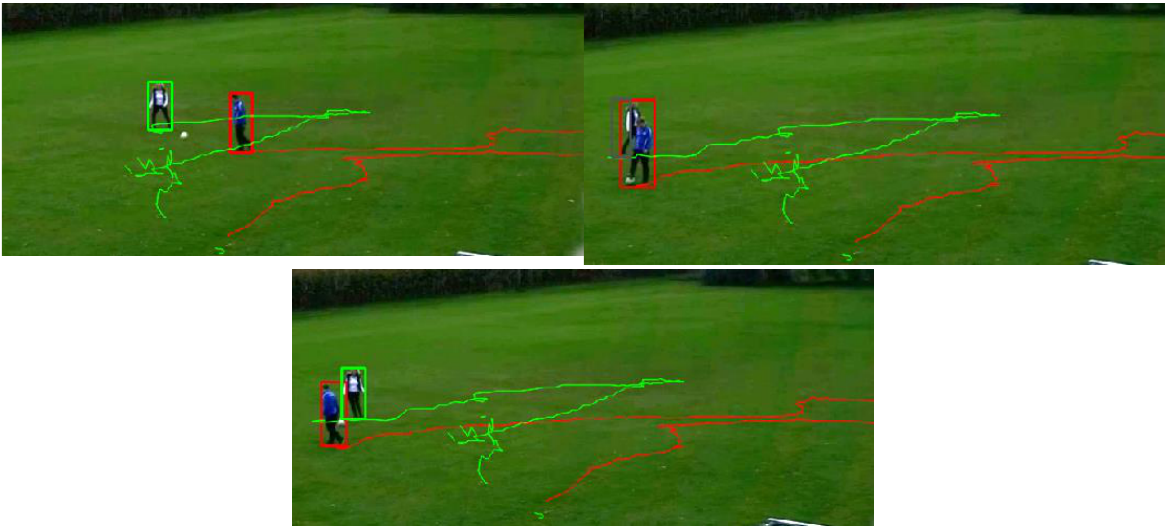
Figure 10. Situation in which a person leaves the field of view for about 8 s. The algorithm manages to keep the correct assignment (sequence from top left to bottom right).